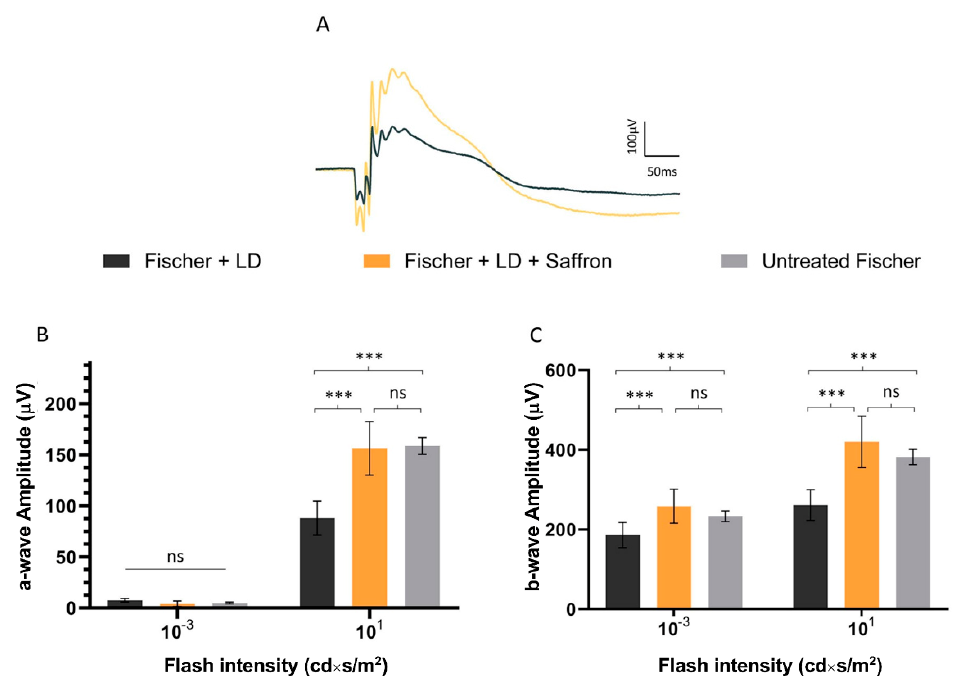
Figure 4. Saffron treatment on the flash electroretinogram response in treated and untreated light damage (LD) Fischer rats. ( A ) Representative traces of the scotopic electroretinographic response in Fischer rats. ( B ) A-wave amplitude at 0.001 cd × s/m 2 and 10 cd × s/m 2 ; ( C ) b-wave amplitude at 0.001 cd × s/m 2 and 10 cd*s/m 2 . n.s. p>0.05; *** p < 0.001; (dark gray: Fischer + LD; orange: Fischer + LD + Saffron; light gray: Untreated Fischer; n = 6; ± SEM; Statistical tests Two way ANOVA followed by Dunnett’s test).